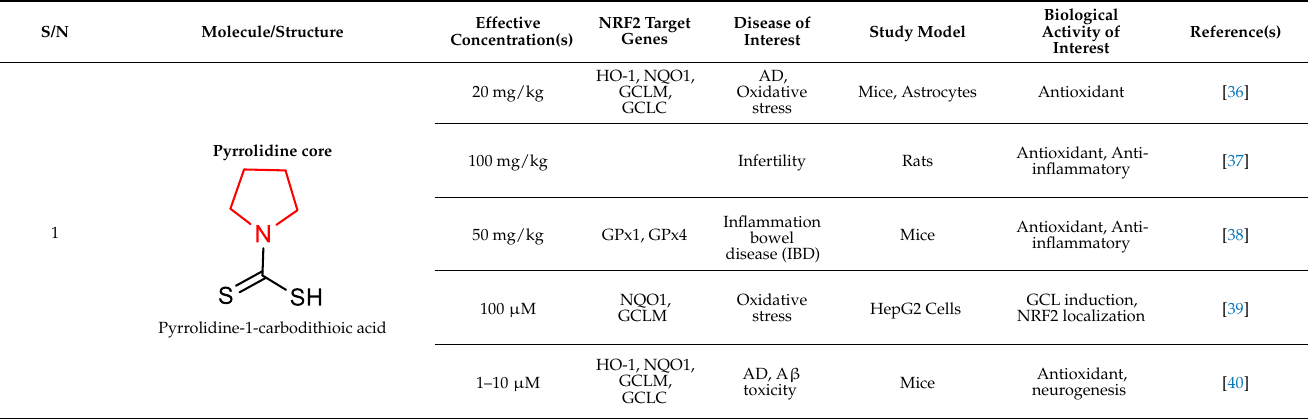
Table 1. Five- and six-membered nitrogen heterocyclic compounds and NRF2-inducing activities.